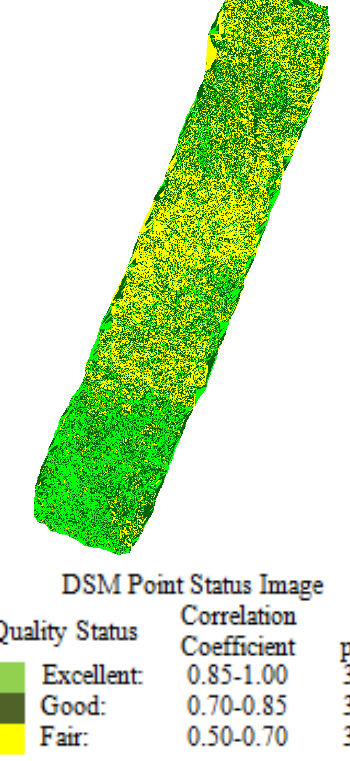
Figure 10. DSM point status image.